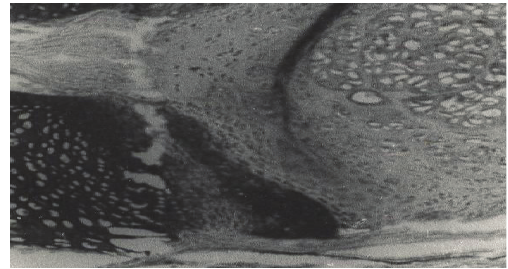
Figure 4: Plate of photomicrograph of normal gill (control) C. gariepinus after 12